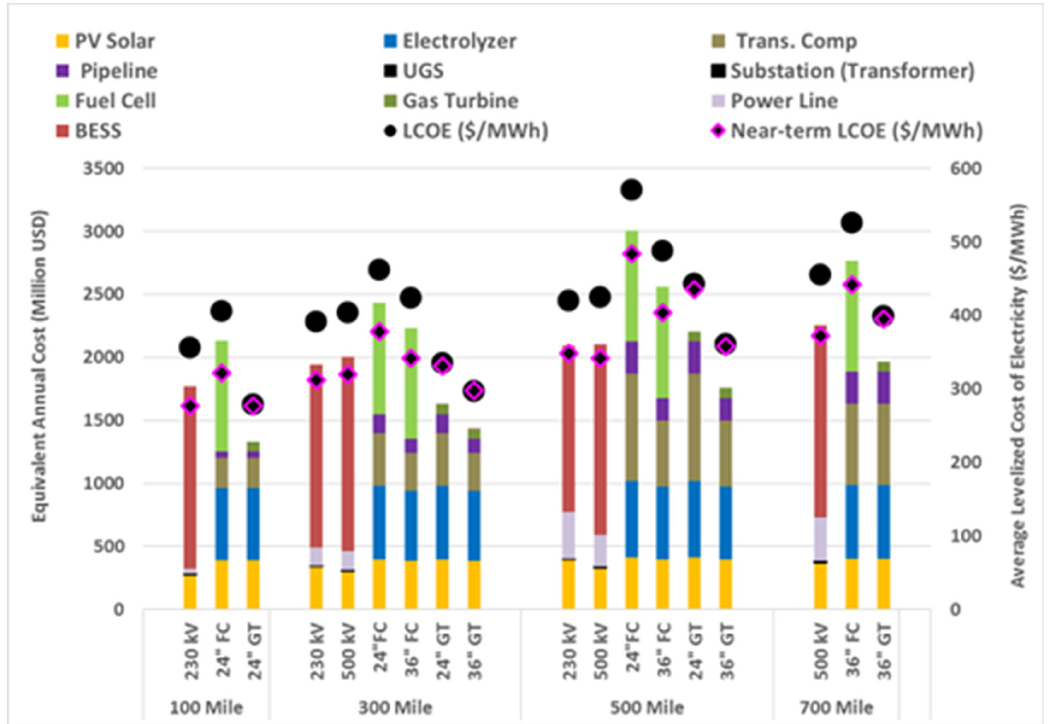
Figure 6. Equivalent annual cost breakdown and levelized cost of electricity. Scenario is for the 1200 MW peak demand scenario in which the all-electric pathway only meets 95% of load and hydrogen pathways meet 100% of load.